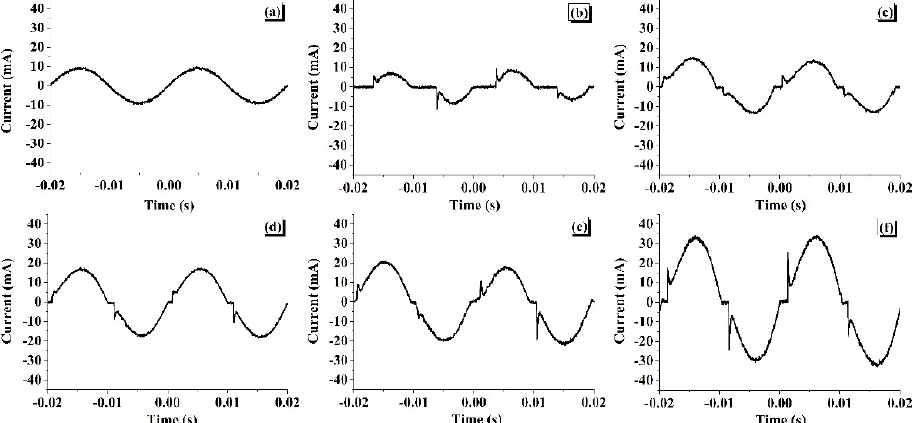
Figure 5. Variation of instantaneous leakage current of the fresh sample at different stages: ( a ) initial period, ( b ) dry band arcing period, ( c ) and ( d ) continuous arcing period, ( e ) hot spot initiation period, ( f ) carbonisation period.